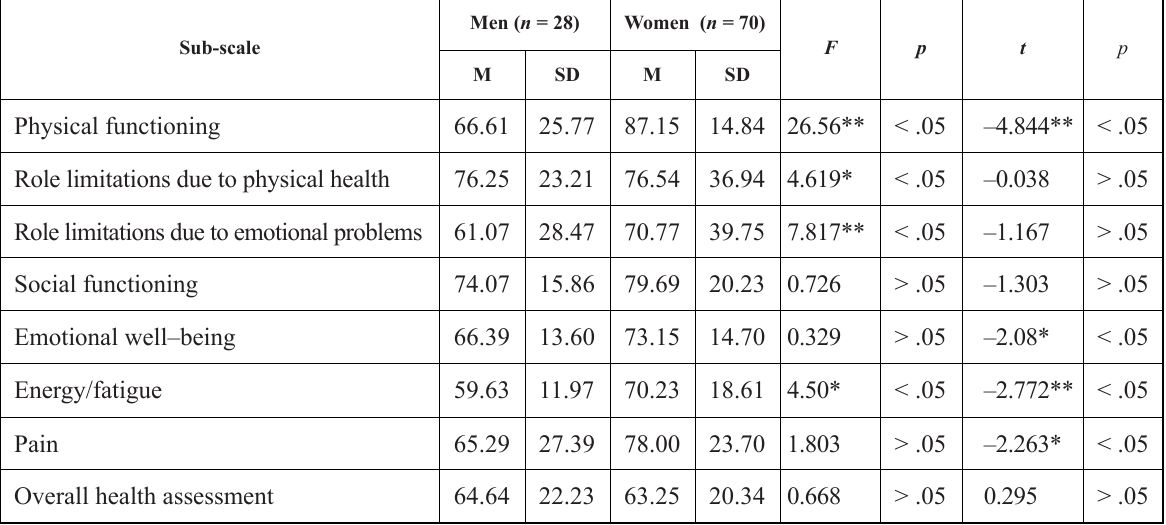
Table 1. Teacher subjective quality of life estimates by gender (Scores)